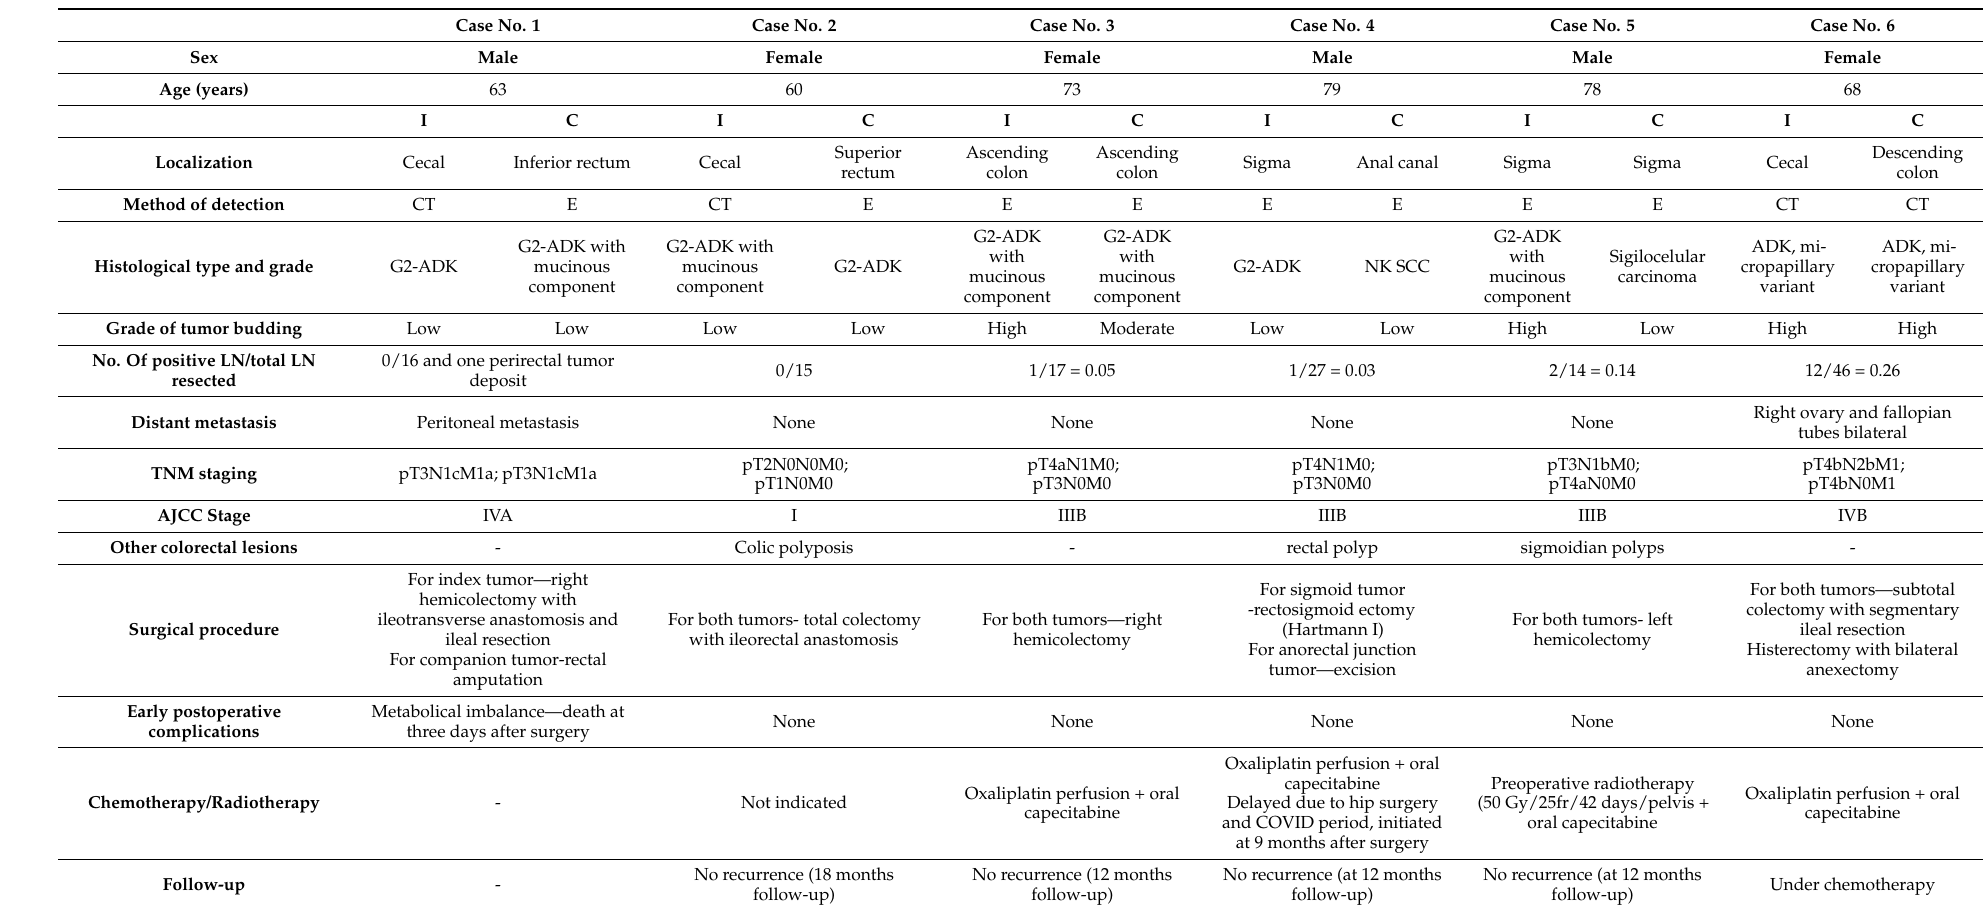
Table 2. Clinicopathological characteristics of the